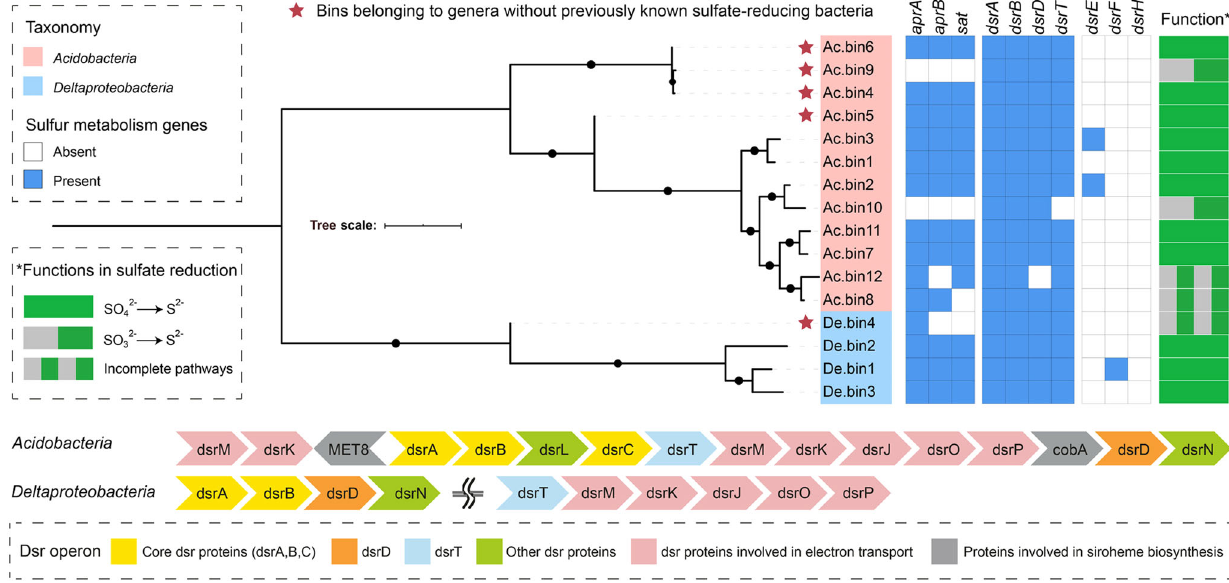
Fig. 1 Analysis of dissimilatory sulfate reduction genes in metagenome-assembled genomes (MAGs) from revegetated acidic mine wastelands. Sixteen medium- to high-quality MAGs (completeness >50% and contamination <10%) were included in the analysis. The functions of the MAGs in sulfate reduction were predicted according to the presence and/or absence of key genes for the pathway. A representative organization of dissimilatory sulfate reduction genes on the MAGs belonging to Acidobacteria and Deltaproteobacteria is displayed, respectively. Tree scale bar = 1. Additional details are provided in Supplementary Tables 1 and